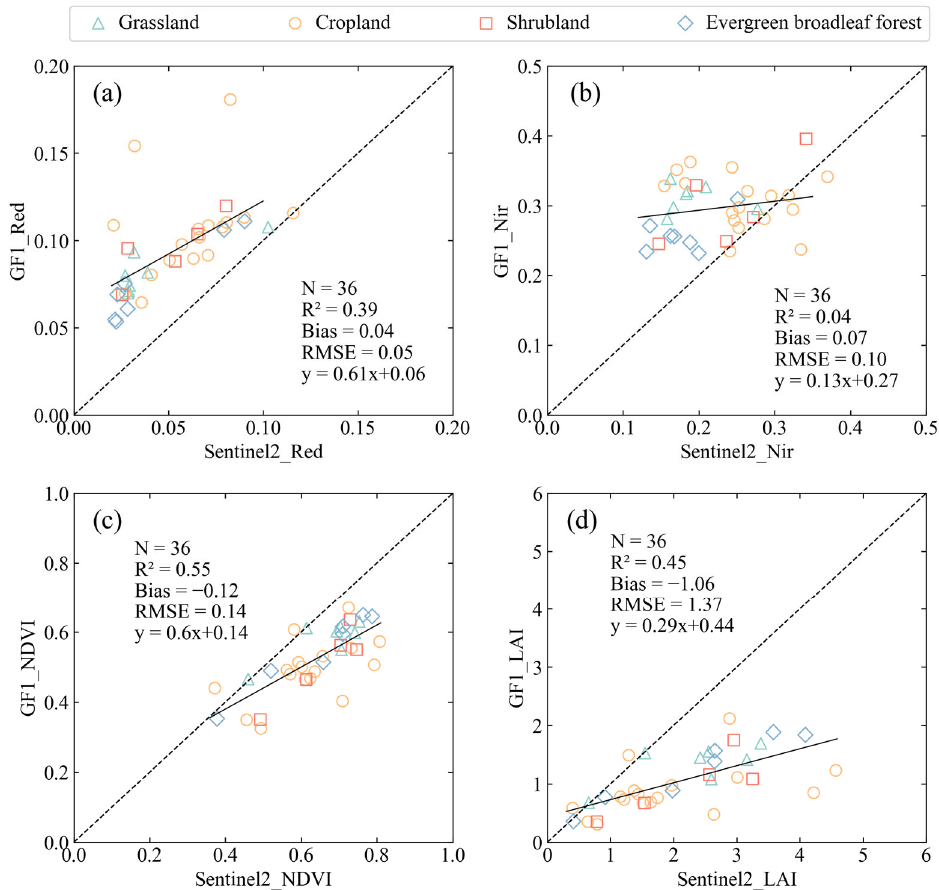
Figure 10. Differences between Sentinel ‐ 2 and GF1 reflectance. ( a ) Differences between red reflec ‐ tance for GF ‐ 1 and Sentinel ‐ 2 data. ( b ) Differences between near infrared reflectance for GF ‐ 1 and Sentinel ‐ 2 data. ( c ) Differences between NDVI from GF ‐ 1 and Sentinel ‐ 2 reflectance. ( d ) Comparison 2 data. ( c ) Differences between NDVI from GF-1 and Sentinel-2 reflectance. ( d ) Comparison of of Sentinel2_LAI and GF1_LAI. Sentinel2_LAI and